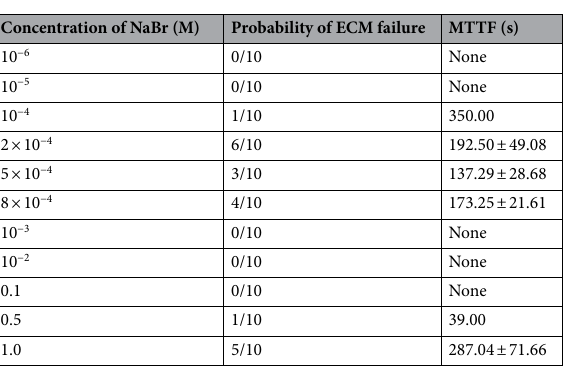
Figure 4. In-situ microscopic images of Sn electrodes at the end (450 s) of the ECM process at 3 V applied bias, in various Br − concentrations: ( a ) 10 −4 M; ( b ) 2·10 −4 M; ( c ) 0.5 M and ( d ) 1.0 M ( C cathode; A anode).